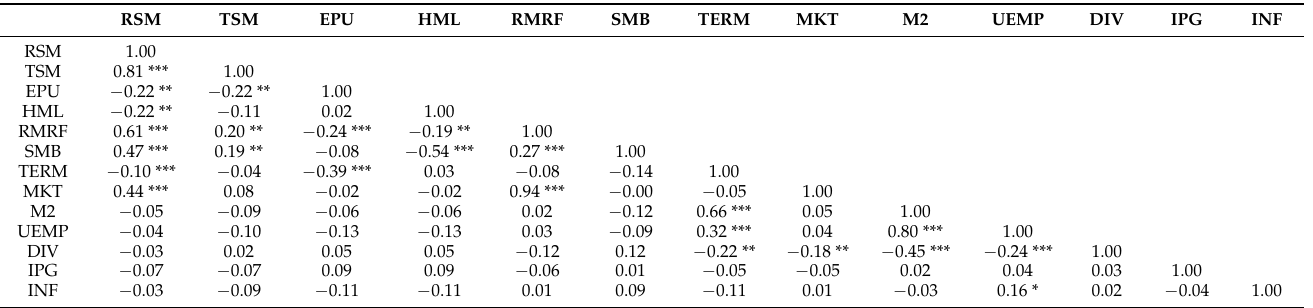
Table 7. Correlation analysis matrix of momentum returns, Fama–French three factors, and macroeco- nomic factors. *** denotes significant at 0.01 level, ** denotes 0.05 significance level, and * represents significant at 0.1 level, respectively.